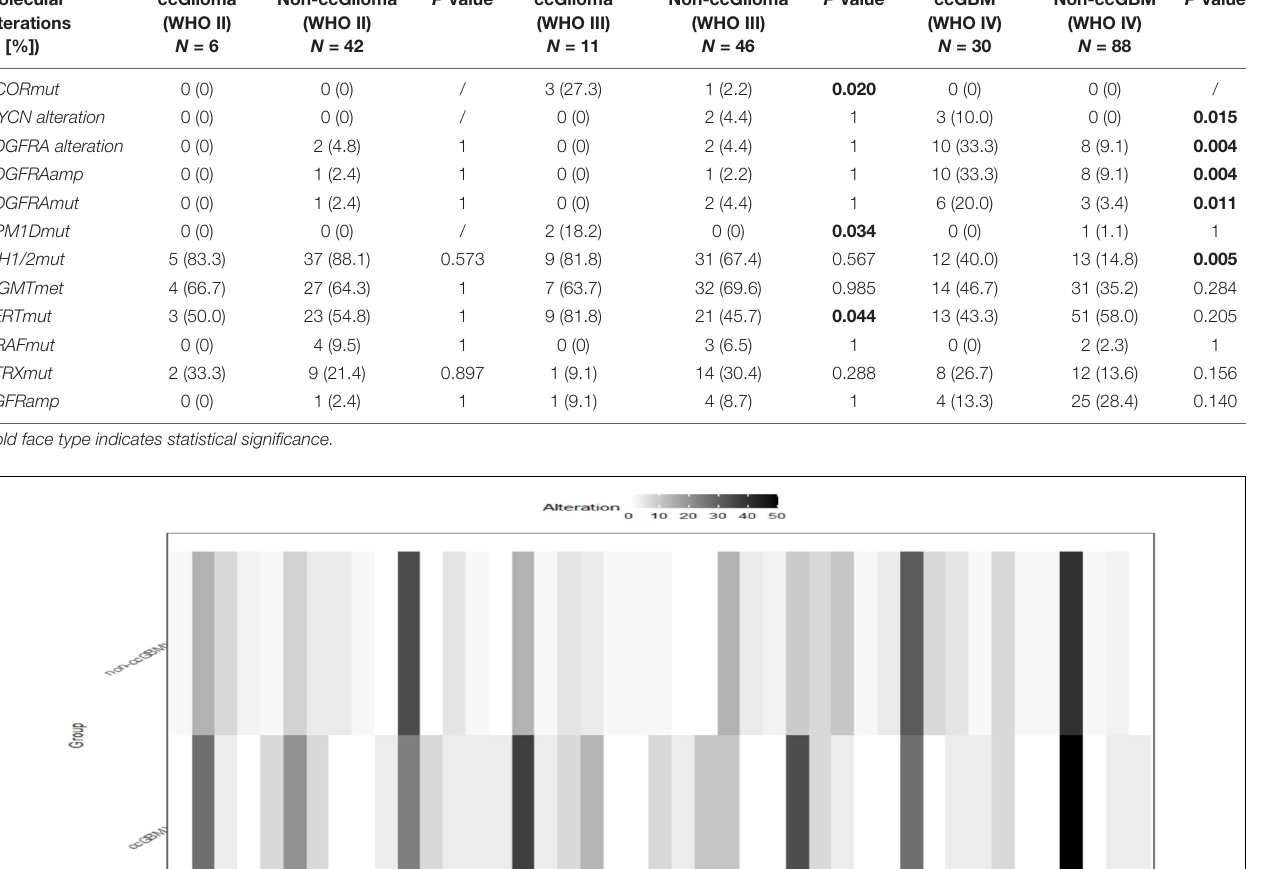
TABLE 1 | Molecular alterations of ccGlioma and non-ccGlioma of different WHO grades by univariate logistic regression. Molecular alterations